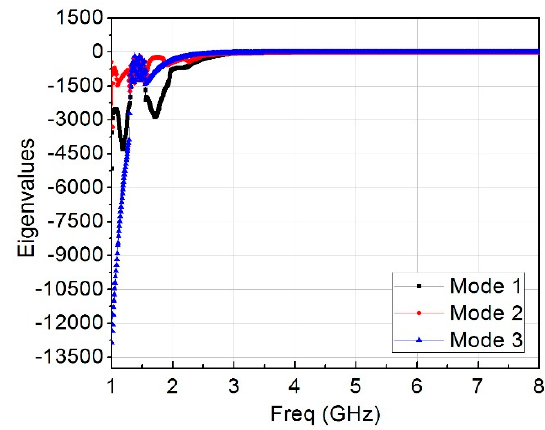
Figure 14. Eigenvalues of three modes at 5.8 GHz.